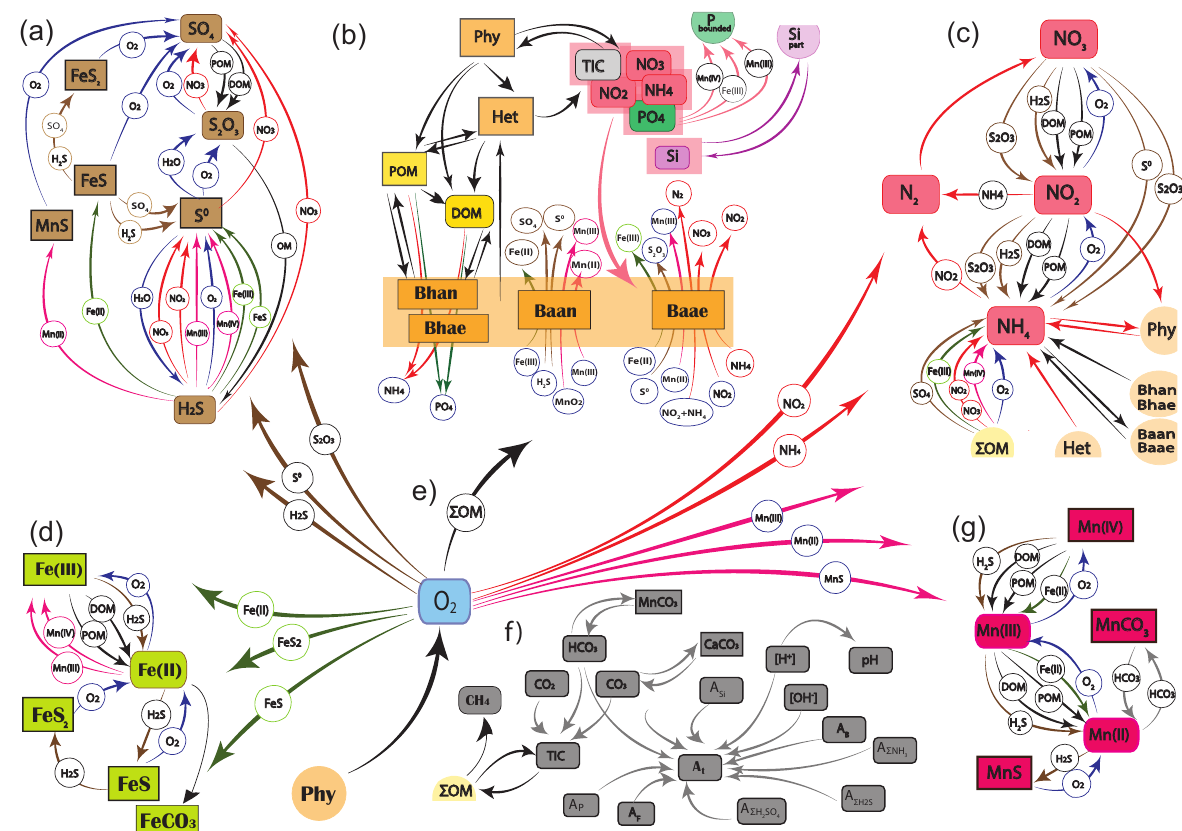
Figure 1. Flow chart of biogeochemical processes represented in the Benthic RedOx Model (BROM), showing the transformation of sulfur species (a) , the ecological block (b) , the transformation of nitrogen species (c) , the transformation of iron species (d) , the processes affecting dissolved oxygen (e) , the carbonate system and alkalinity (f) , and the transformation of manganese species (g)